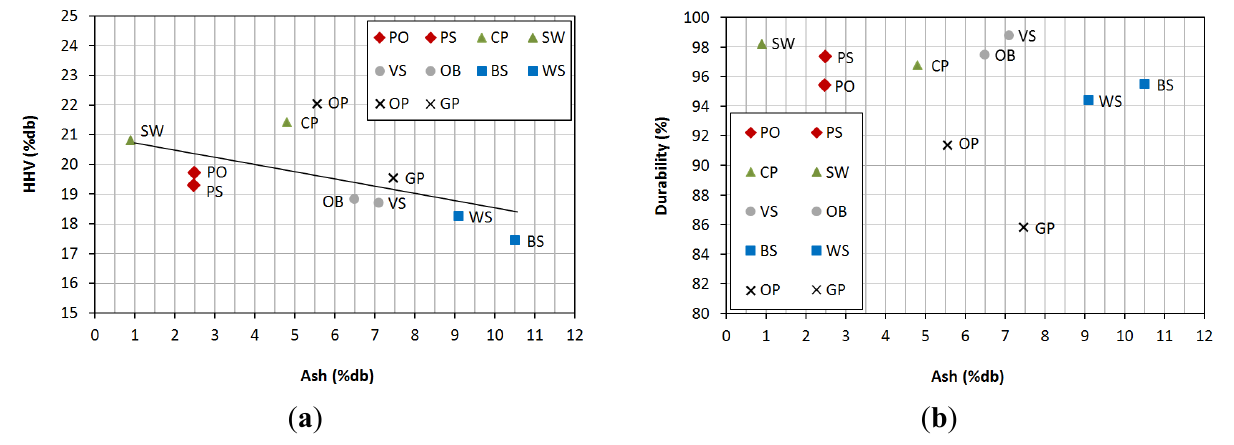
Figure 3. Relationship between ( a ) ash and HHV ; ( b ) ash and